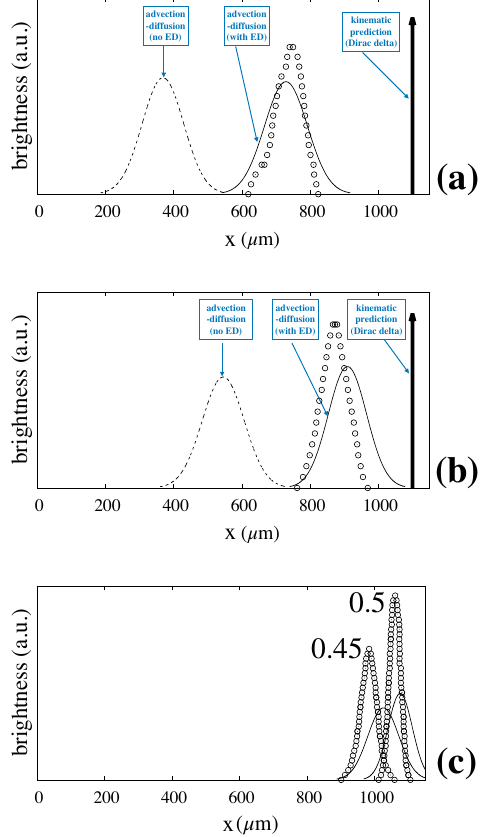
Figure 10. Fully predicted particle exit distributions vs. experimental values taken from Ref. [6]. Symbols and lines are consistent with those of Figure 9. ( a ) r p = 0.35 µ m; ( b ) r p = 0.4 µ m; ( c ) r p = 0.45; 0.5 µ m.